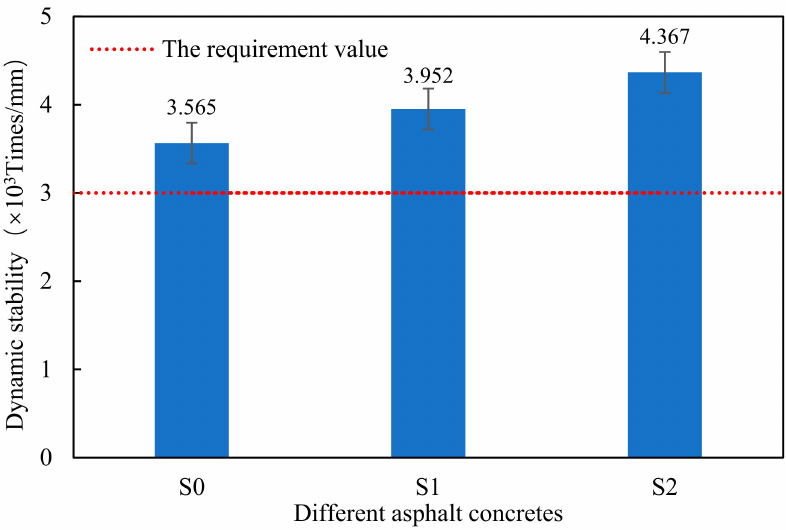
Figure 8. Dynamic stability of different asphalt